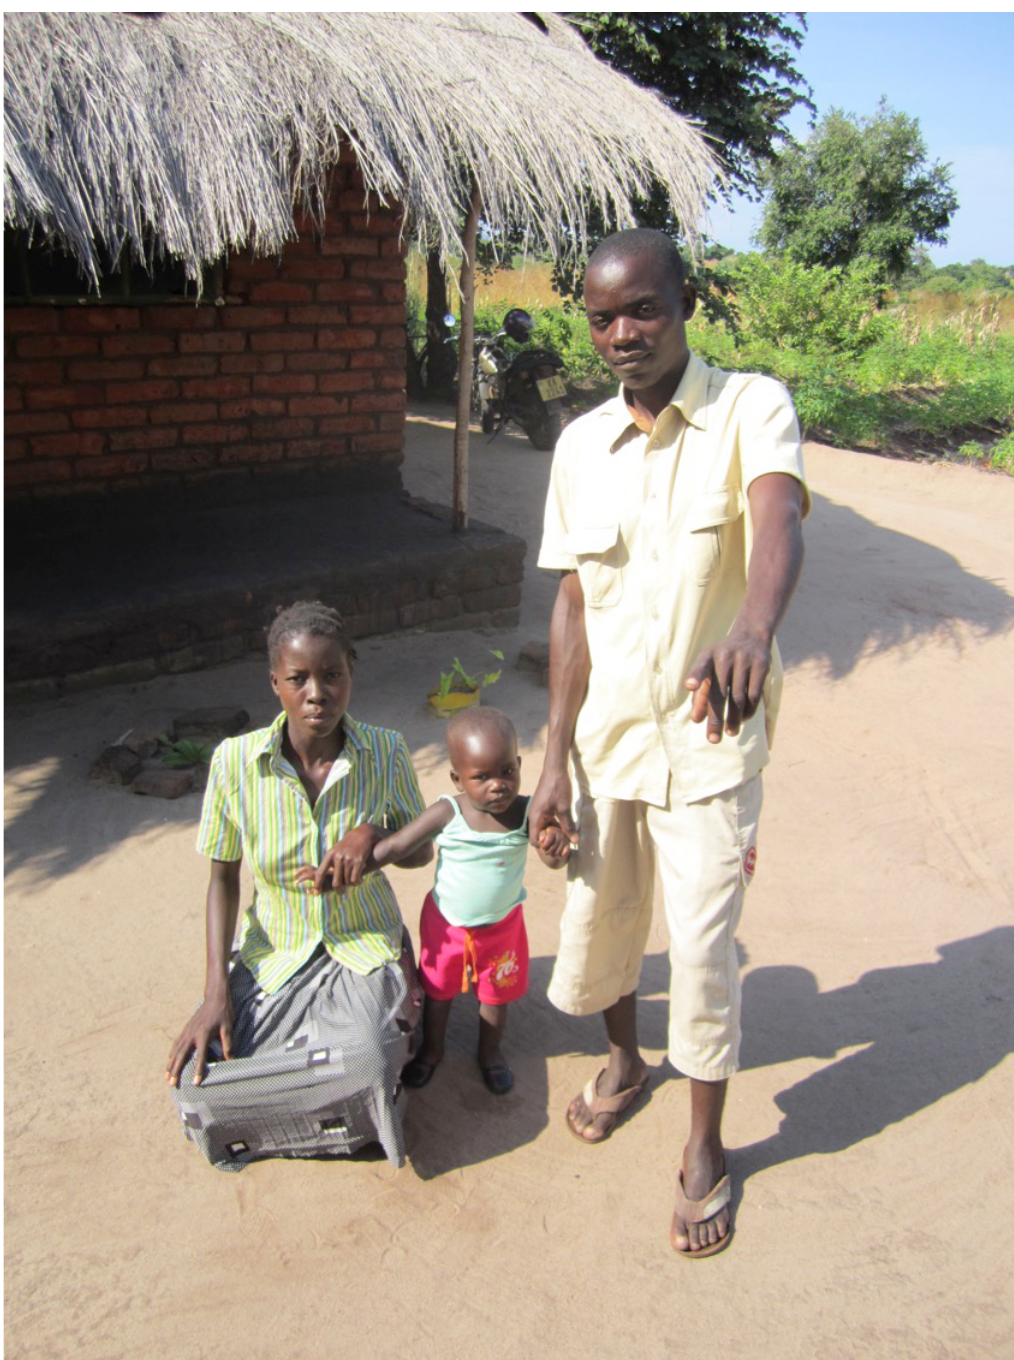
Photograph 4: Farmer and part-time NGO worker (26) with his wife and their first